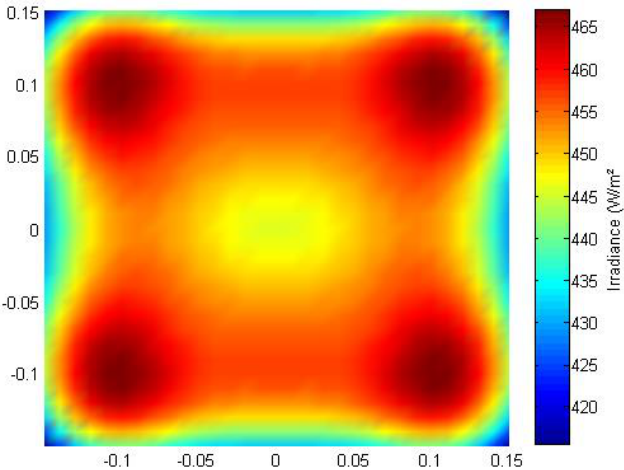
Figure 12. Irradiance distribution for optimal configuration obtained with a multiple objective genetic algorithm for a number of 36